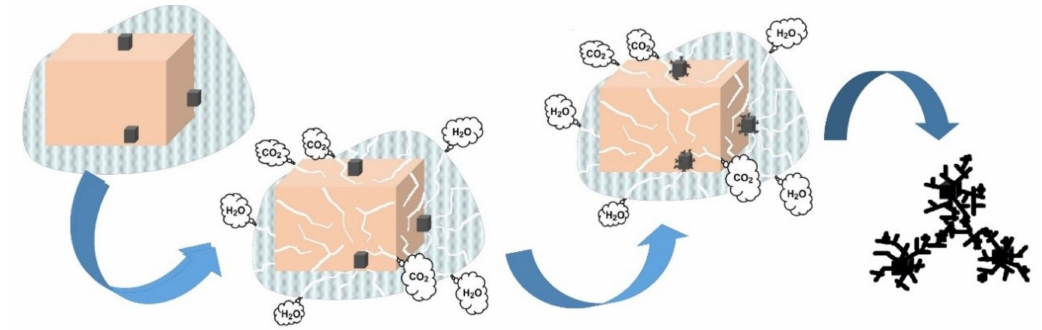
Figure 3. TEM ( A ) and AFM ( B , C ) images of the material obtained in the course of thermal transformation of the reaction mixture into α -MnO 2